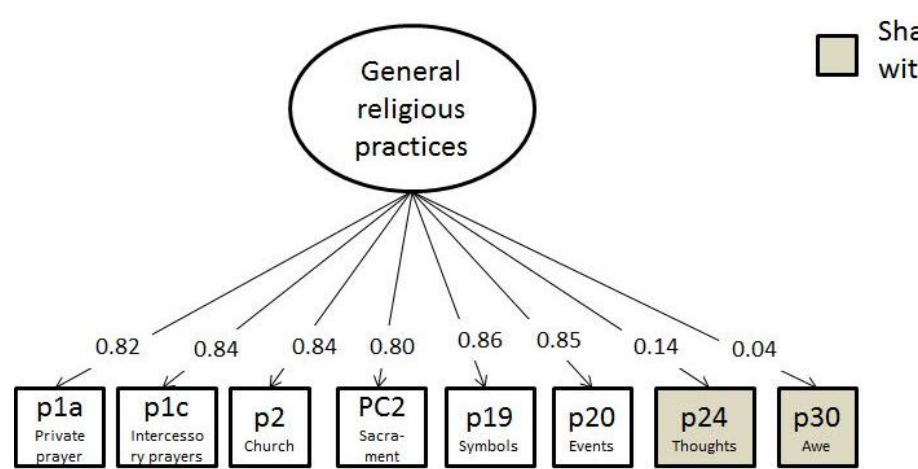
Figure 3. Factor General religious practices from SEM.